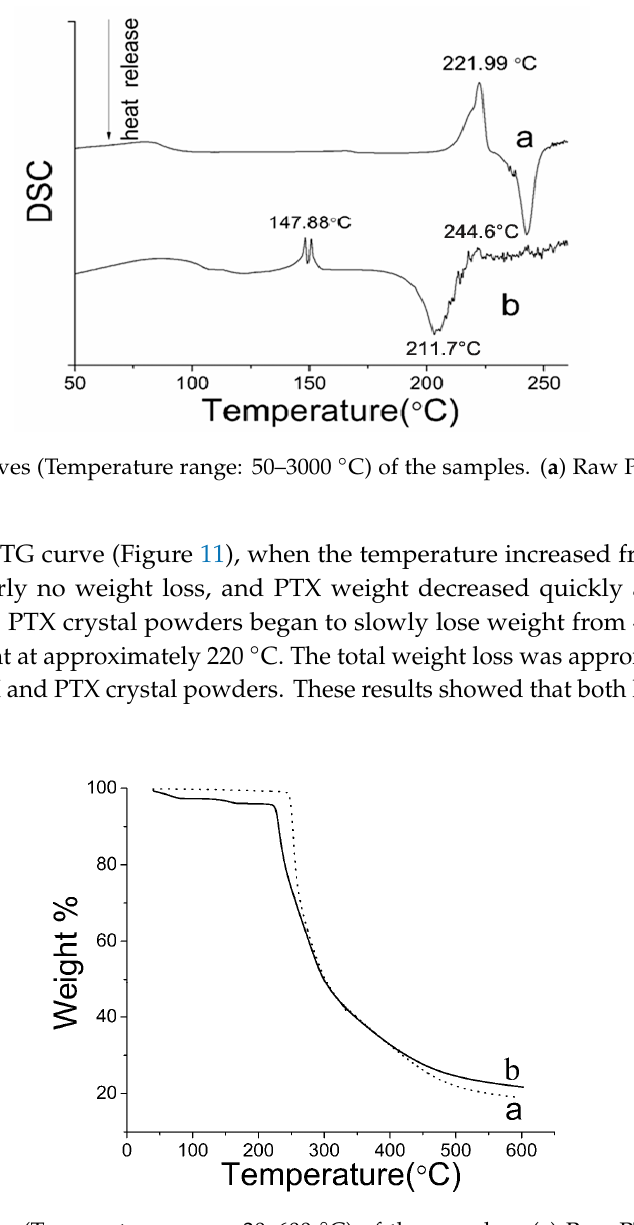
Figure 11. TG curve (Temperature range: 30–600 °C) of the samples. ( a ) Raw PTX; and ( b ) PTX crystal powders.